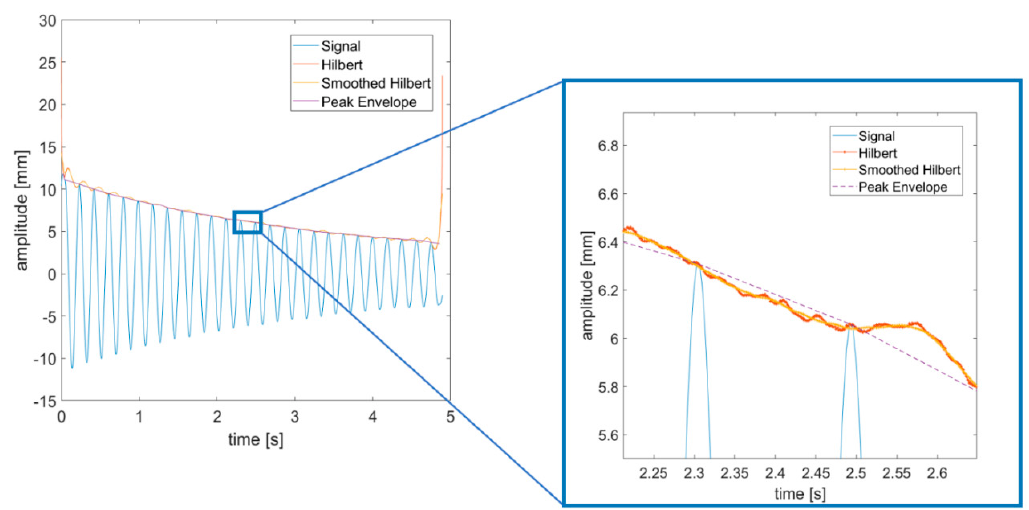
Figure 4. Estimation of instantaneous amplitude (to the left) with a zoom (to the right). Video-acquired data, free decay (Marker #0). Acquisition rate: 1000 fps.